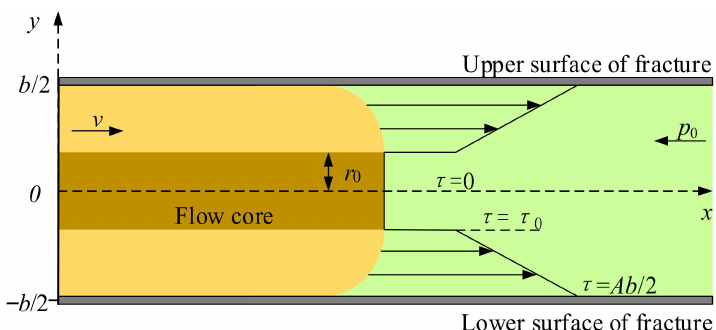
Figure 3. Sectional shear force distribution